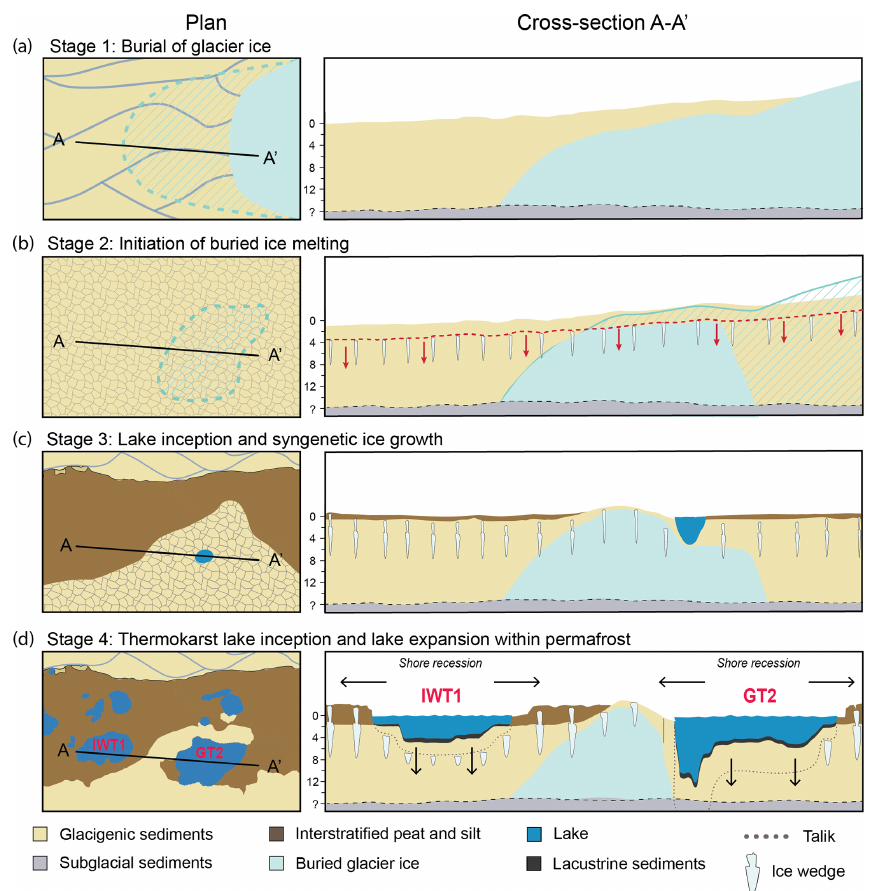
Figure 7. Schematic diagram showing the sequence of formation of lakes in terrain underlain by relict glacier